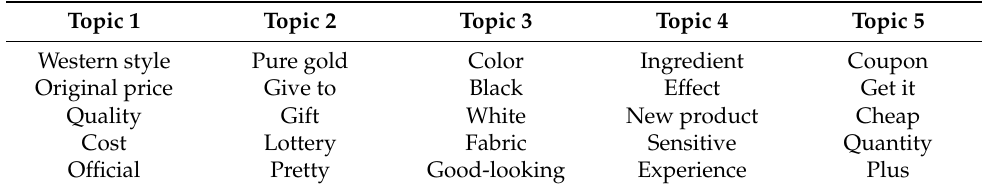
Table 2. Subject classification of host language